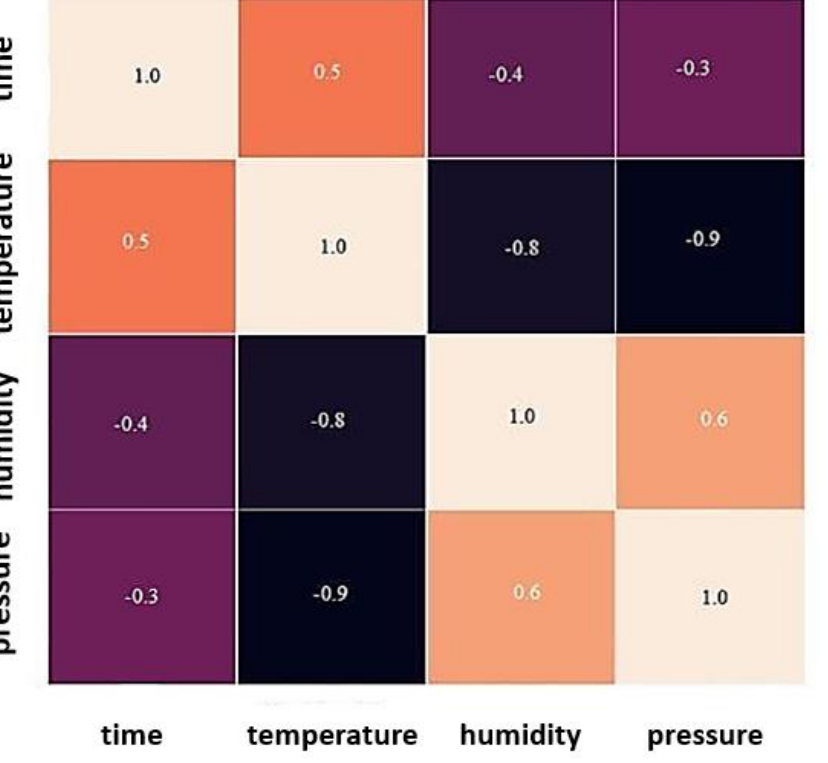
Figure 7. Correlation Matrix.